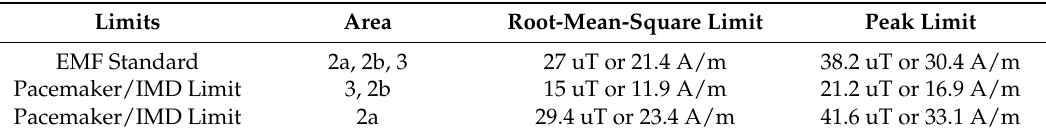
Table 5. General public basic restriction of magnetic field.